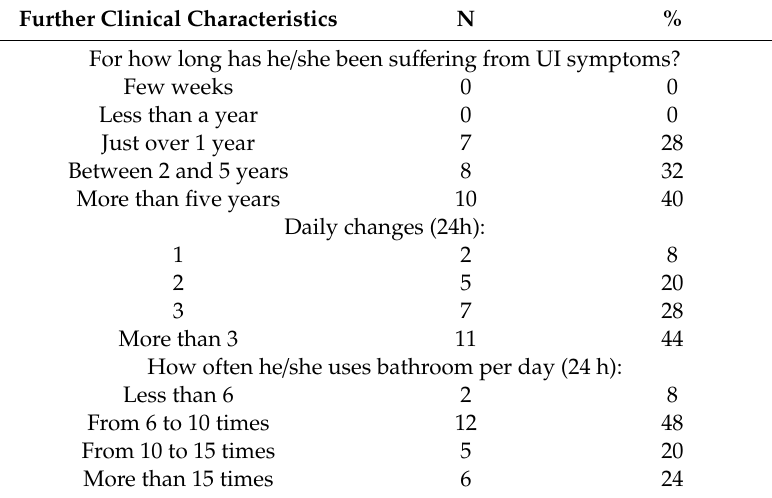
Figure 2. This figure shows the most represented urinary incontinence causes in the sample. Table 2. This table shows the clinical characteristics of